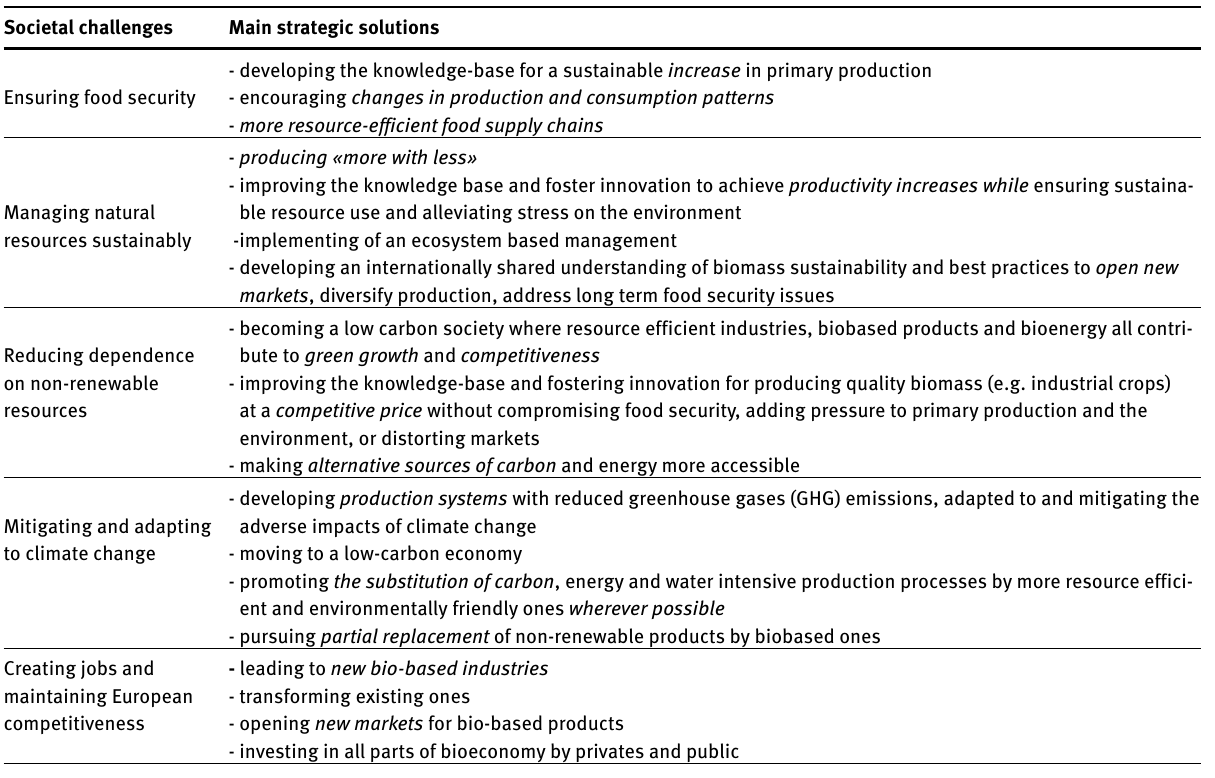
Table 2: “Innovating for Sustainable Growth: a Bioeconomy for Europe”: the societal challenges and the main strategic solutions.